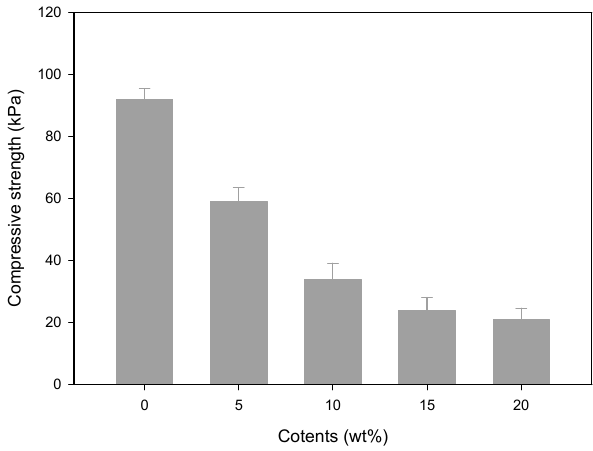
Figure 4. Compressive strength of CH–CMC hydrogels with different content of honey; radiation dose is 75 kGy.